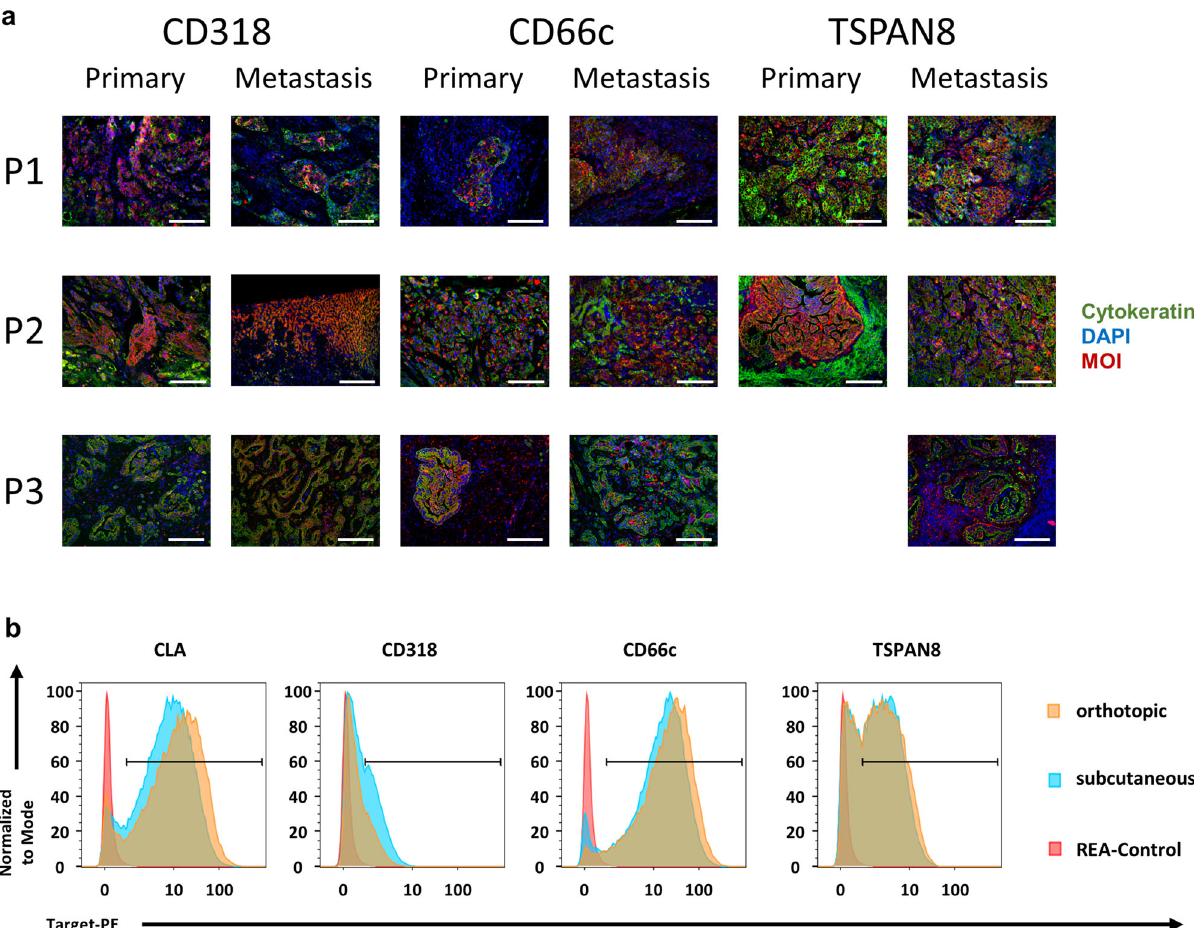
Fig. 2 Target expression is preserved in human metastases and upon subcutaneous or orthotopic transplantation. a Target candidate staining of three independent primary PDACs and matched metastases. Cell nuclei were stained with DAPI (blue), tumor cells by cytokeratin (green), marker of interest (MOI) is depicted in red. P1 and P3 metastases are of lymph node origin, P2 is liver derived. Images are representative for one stained sample. b Flow cytometry staining of target candidates on dissociated PAXF1872 PDX cells transplanted either orthotopically (blue) or subcutaneously (yellow). Respective isotype control is indicated in red. Scale bar = 150 µ m for all tissues except for P2, metastasis, CD318 = 300 µ m. P = patient. TSPAN8 staining of primary PDAC from P3 not available due to technical